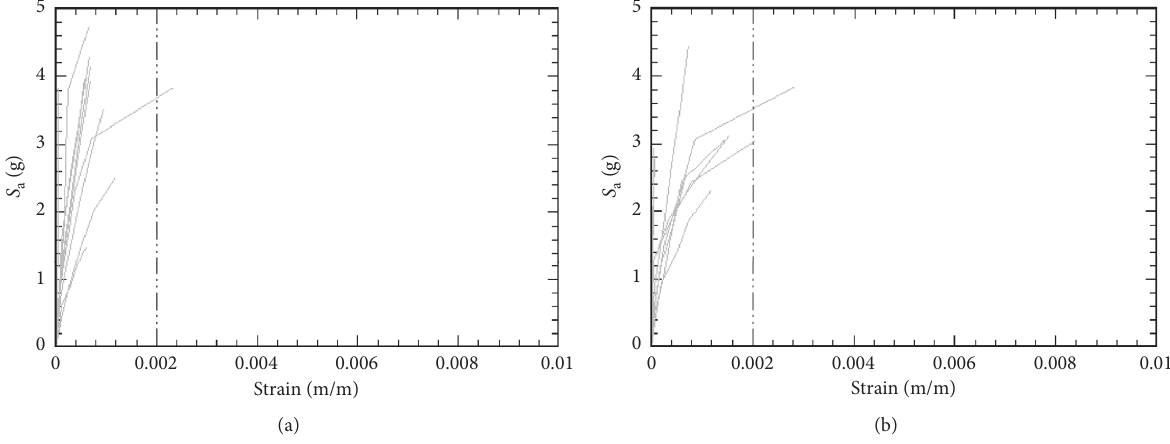
Figure 8: IDA curves considering concrete strains as EDP for (a) the long-duration set and (b) the short-duration